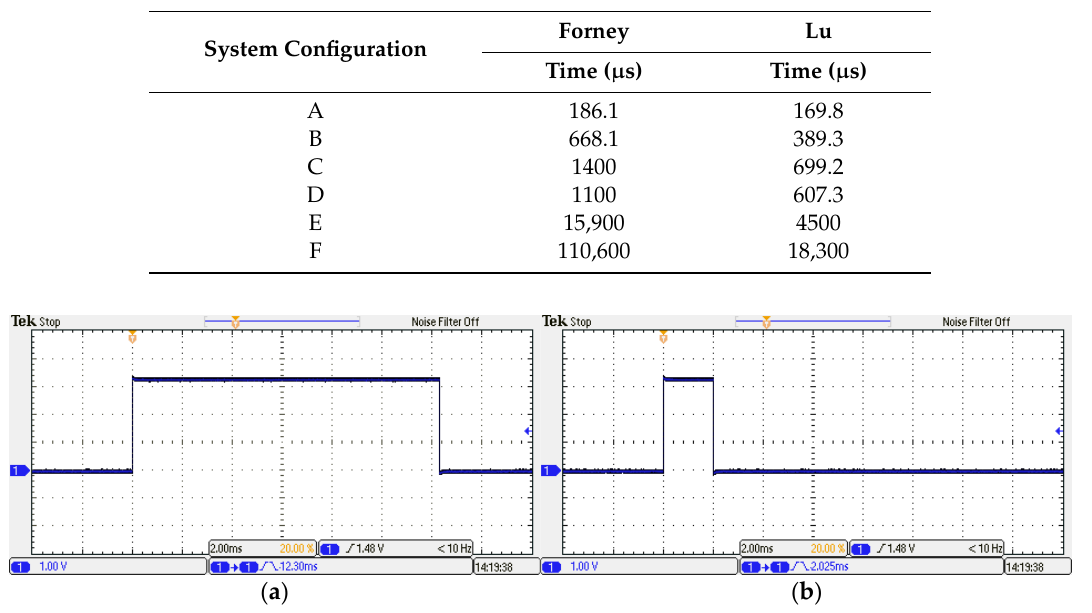
Table 5. Microcontroller unit (MCU) implementations results.